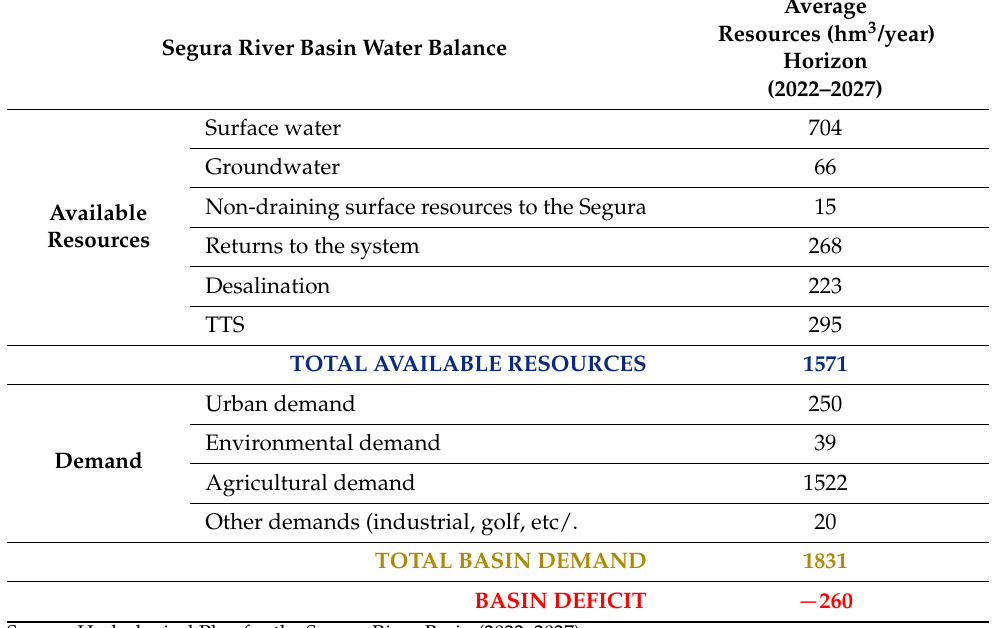
Table 5. Segura River basin water balance